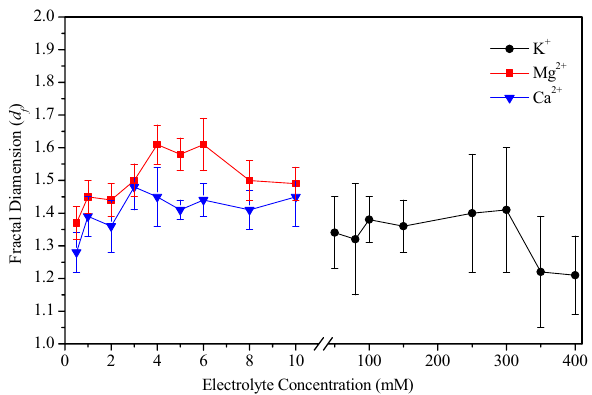
Figure 3. Fractal dimension of BSC aggregates in different K + , Mg 2+ and Ca 2+ electrolyte concentrations. Data are expressed as the mean ± standard deviation of triplicate